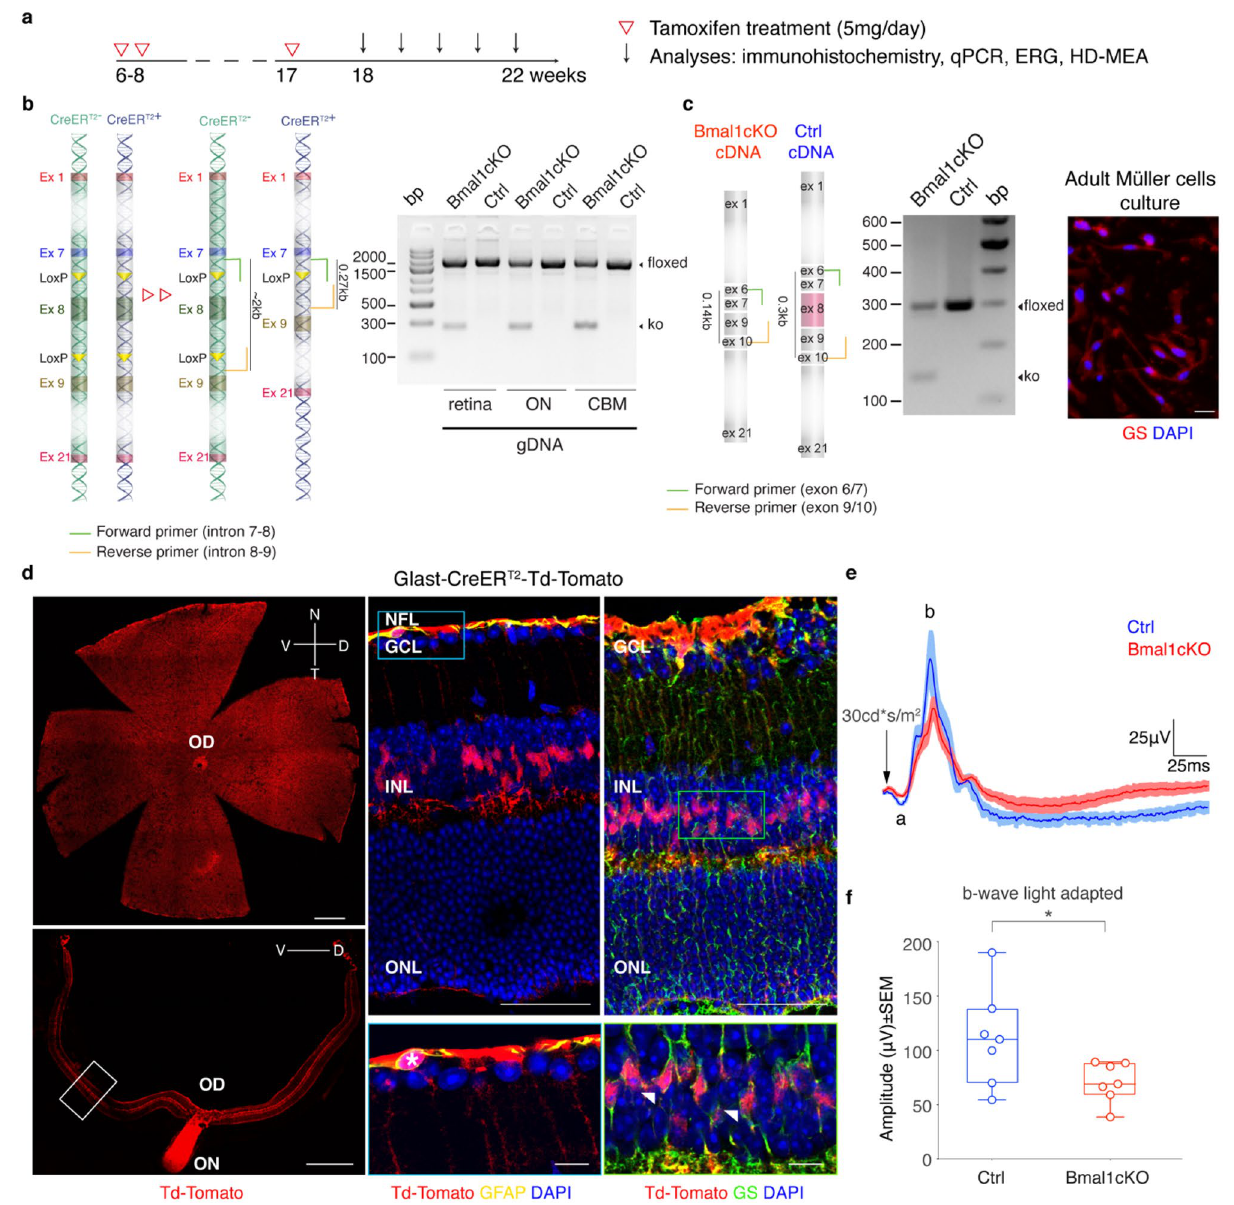
Figure 1. Bmal1 exon 8 deletion in GLAST + retina cells (astrocytes and Müller cells) reduces b-wave amplitude in photopic ERG. (a) Schematic representation of the experimental design. Ctrl and Bmal1 cKO mice were orally administered on postnatal weeks 6–8 with tamoxifen (5 mg) for 2 consecutive days. A third treatment was repeated one week before the experiments. (b) DNA schematics (left panel): transparent color boxes, introns; solid color boxes, exons; triangles, lox P sites; black bars, sizes of PCR products diagnostic of genotypes. PCR products amplified from the retina, optic nerve (ON), and cerebellum (CBM) genomic DNA (gDNA) demonstrate the deletion of exon 8 in Bmal1 cKO mice (0.27 kb) after TM treatment. (c) cDNA schematics: grey and red boxes, exons; black bars, sizes of PCR products. Bmal1 exon 8 deletion from adult Müller cells of Bmal1 cKO after TM treatment was tested by PCR using primers described in the figure (left). Amplified PCR products show fragments diagnostic of disrupted Bmal1 allele in Bmal1 cKO (PCR product 0.14 kb). On the right, representative immunocytochemistry indicates cultured cells as Müller cells GS positive (red). Scale bar, 20 μm. (d) Glast-CreER T2 -Td-Tomato reporter expression throughout the retina, in the whole mount, and the transverse retina (left panel) following TM treatment. Cre recombinase activity is confined explicitly to astrocytes GFAP positive (yellow, a white asterisk in the magnification below) and Müller Cells GS positive (green, white arrow in the magnification below) (right panels). GFAP, Glial fibrillary acidic protein; GS, Glutamine synthetase; OD and ON, optic disc and nerve; GCL, ganglion cell layer; INL, inner nuclear layer, and ONL, outer nuclear layer. Scale bars: left 500 μm, right upper 50 μm, and right bottom 10 μm. (e) Photopic light-adapted ERG averaged waveforms (mean ± SEM) elicited by 1 Hz flashes of 30 cd s/m 2 for Ctrl (n = 7, blue) and Bmal1 cKO (n = 7, red) mice (a-and b-waves are labeled on the waveforms). (f) Quantification of fERG responses showing b-wave amplitude reduction by ~ 36% in Bmal1 cKO mice under light-adapted conditions (cone pathway ERG). Data are shown as mean ± SEM; animals were recorded at ZT6, *P < 0.05 vs. Ctrl, Student’s t